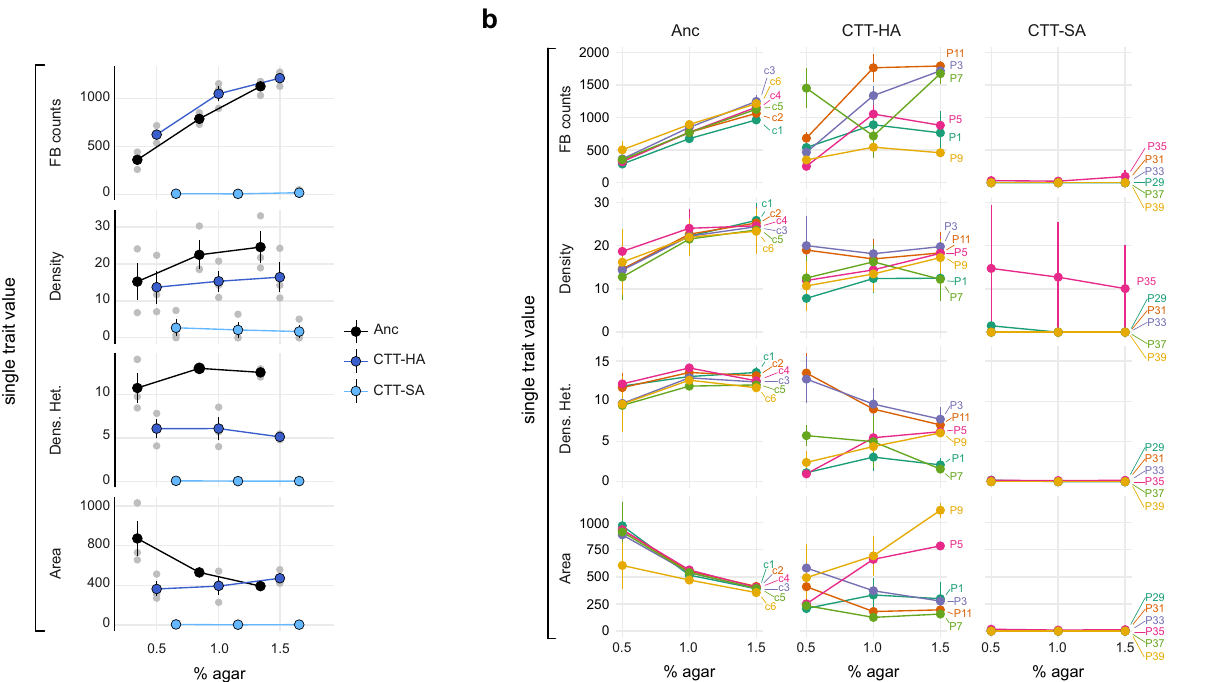
Fig. 3 Deterministic and stochastic evolution of latent reaction norms. Reaction norms of four morphological traits across three agar concentrations (0.5, 1.0, and 1.5%, x-axis in both panels). a Reaction norms across ancestral clones (black circles and lines) and treatment-level average trait values (CTT-HA and CTT-SA evolved populations, dark and light blue circles and lines, respectively). n = 3 independent replicates (gray circles). b Reaction norms for each individual Anc sub-clone (c1 – c6) and each TS-abiotic evolved population across the three biological replicates ( n = 3). Labels at the end of each reaction norm indicate the identity of the ancestral clone or evolved population. In both a and b , large circles and error bars indicate the mean ± SEM, respectively. (Signi fi cance of variables ’ contribution and their interaction were calculated for both a and b with two-way ANOVA. Employed models and results of all comparisons are reported in Data Fig.